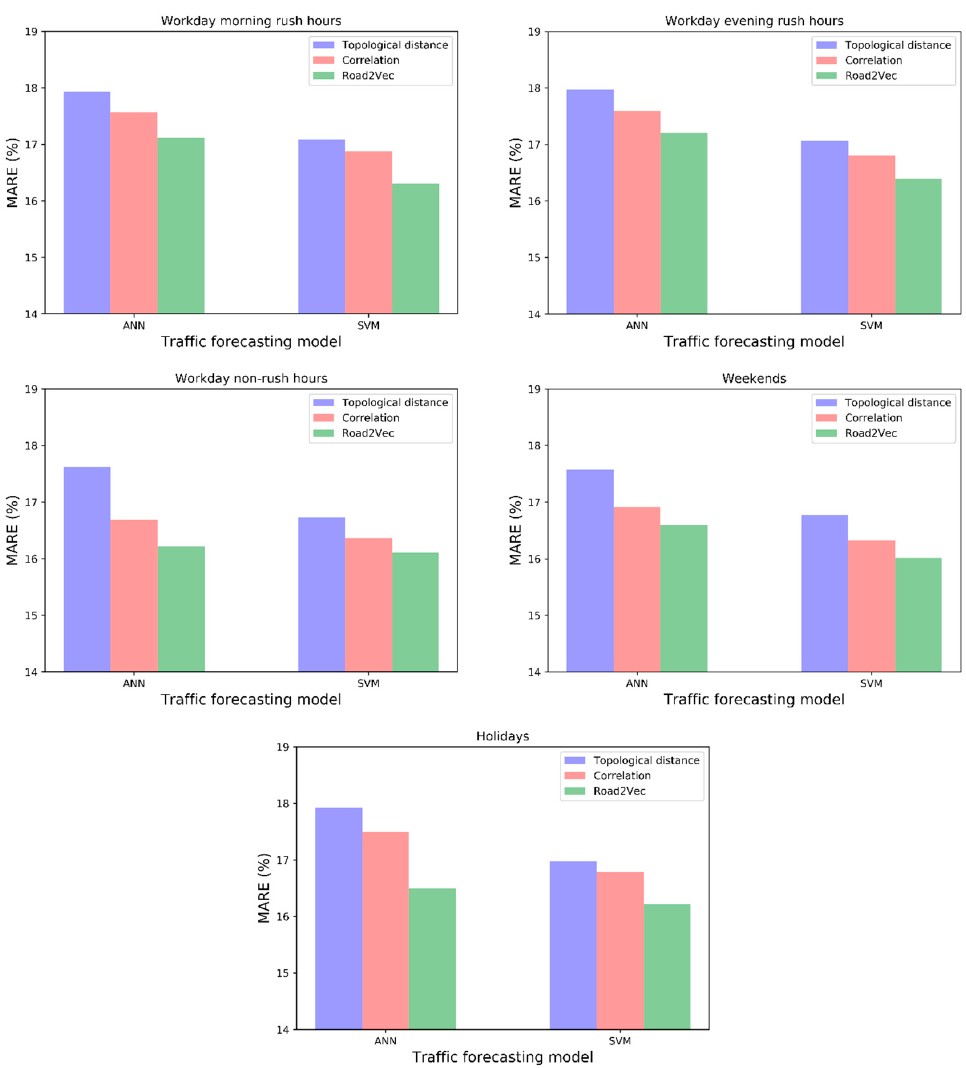
Figure 5. The performance of traffic forecasting models enhanced by different traffic interaction measurement methods.